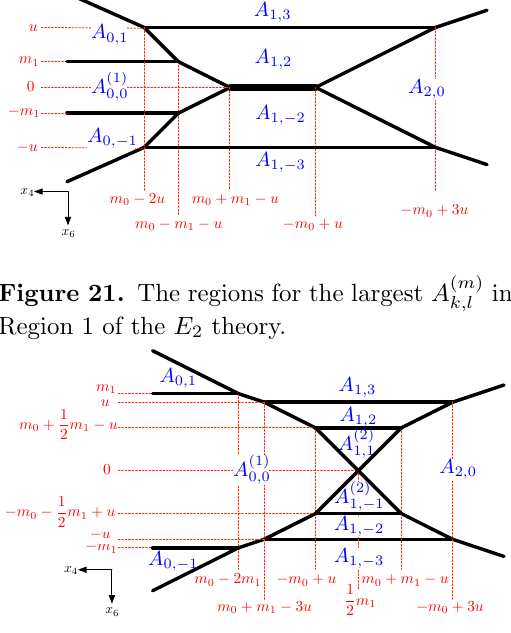
Figure 23. The regions for the largest A ( m ) Region 3 of the E 2 theory.